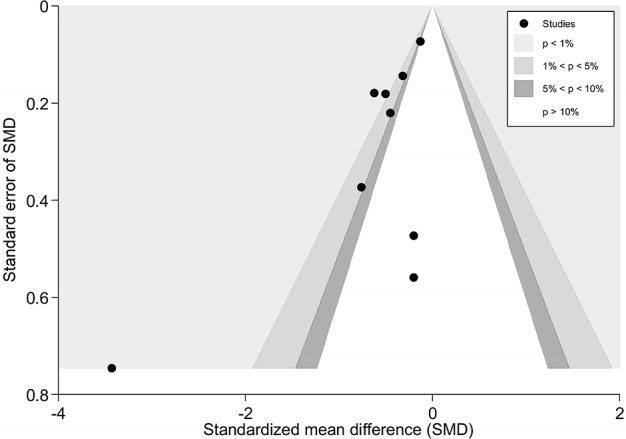
Contour-Enhanced Funnel Plot of Acupuncture versus Sham-acupuncture for CLBP in Pain at immediate term.Visual inspection of the funnel plot suggested some degree of asymmetry. Specifically, there was a relative lack of trials with negative results (i.e., fewer trials in areas of statistical nonsignificance), indicating a potential for publication bias; meanwhile, the dot on the lower left part of the Figure suggested an evidence of small-study effect.